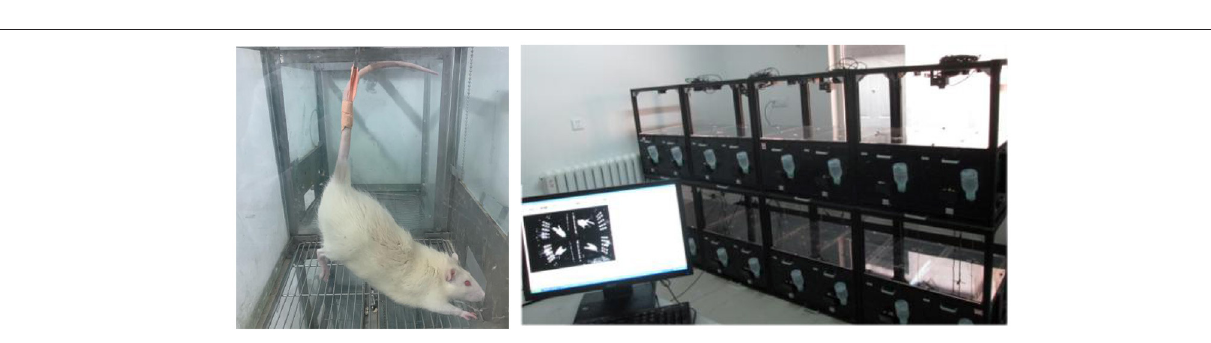
FIGURE 2 | Rats in HLSI and the instrument for